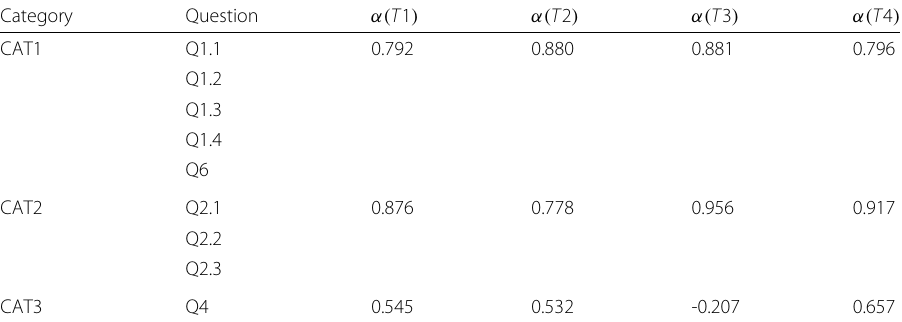
Table 2 Internal consistency measured by Cronbach’s Alpha for individual classes, T1 to T4 (based on Ferreira et al.